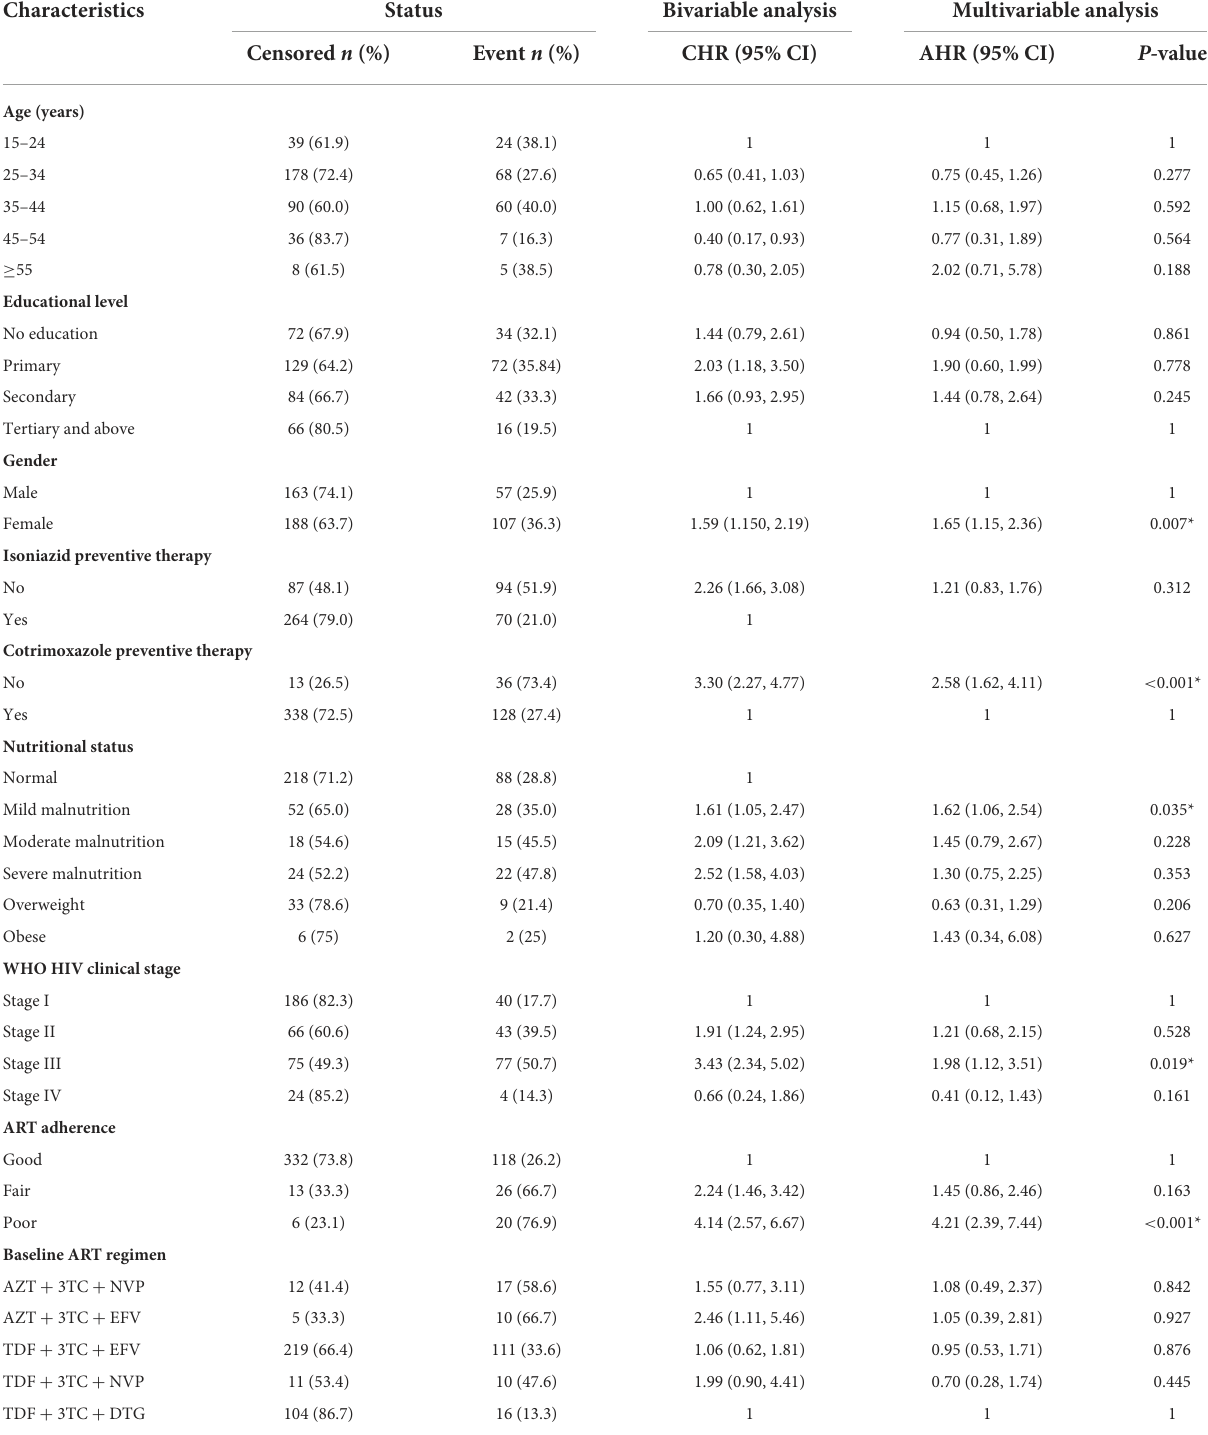
TABLE 3 Bivariable and multivariable Weibull regression analyses of OI predictors among adolescents and adults after the initiation of ART at WSUCSH, Southern Ethiopia, 2012–2021 ( n = 515).